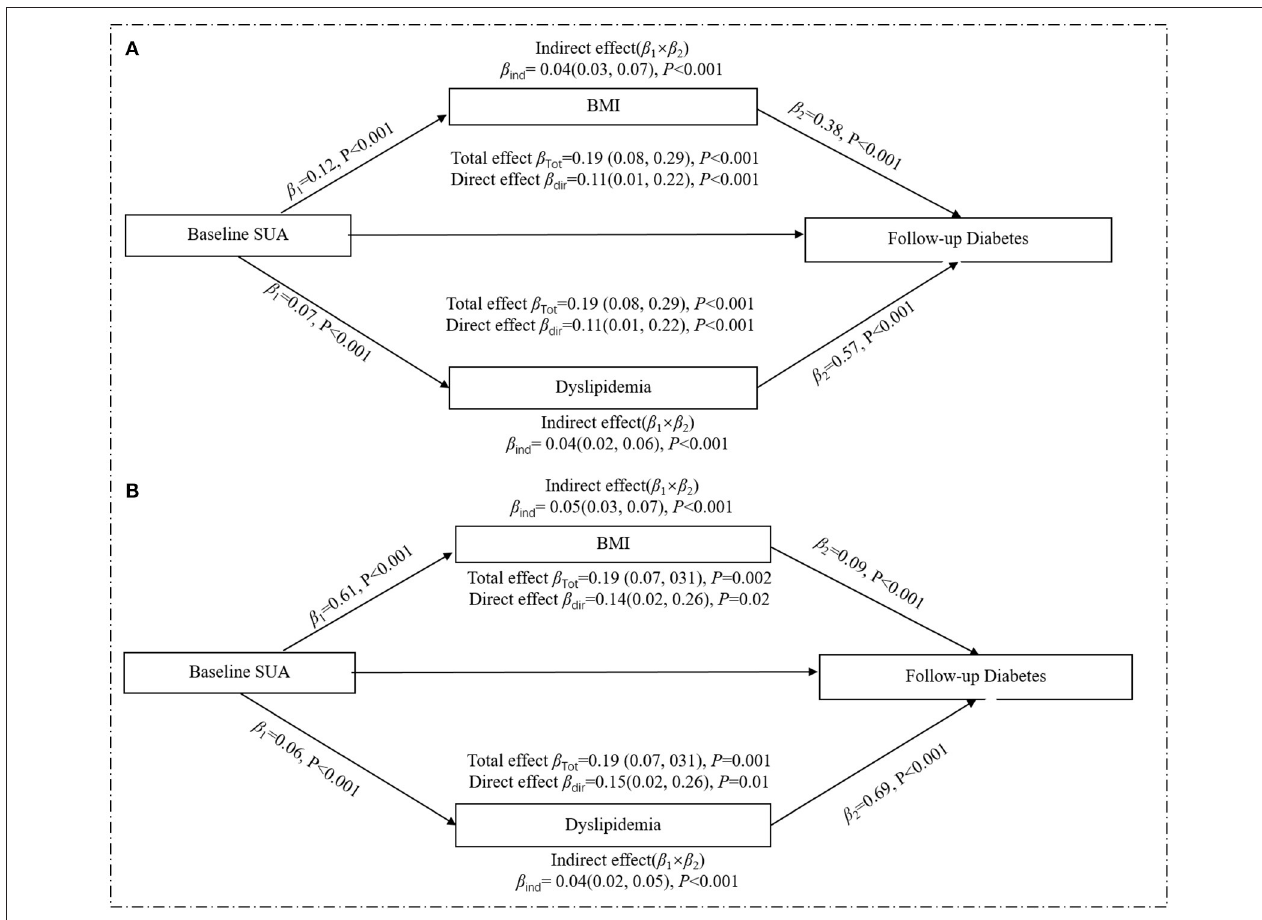
FIGURE 4 | Mediation effect of baseline obesity on the relation of baseline SUA and risk of diabetes in the women. (A) included all women ( n = 4,835); (B) included the postmenopausal female subgroup ( n = 3,290). All analyses were adjusted age, marital status, education background, smoking, drinking, high-sensitivity C-reactive protein, menopausal status, and eGFR. The total effect is the effect of SUA on diabetes without considering BMI or dyslipidemia; the direct effect is the effect of SUA on diabetes when controlling for BMI and dyslipidemia; the indirect effect is the effect of SUA on diabetes through BMI or dyslipidemia. Mediation effects by BMI or dyslipidemia are calculated by indirect effect/total effect × 100. β , regression